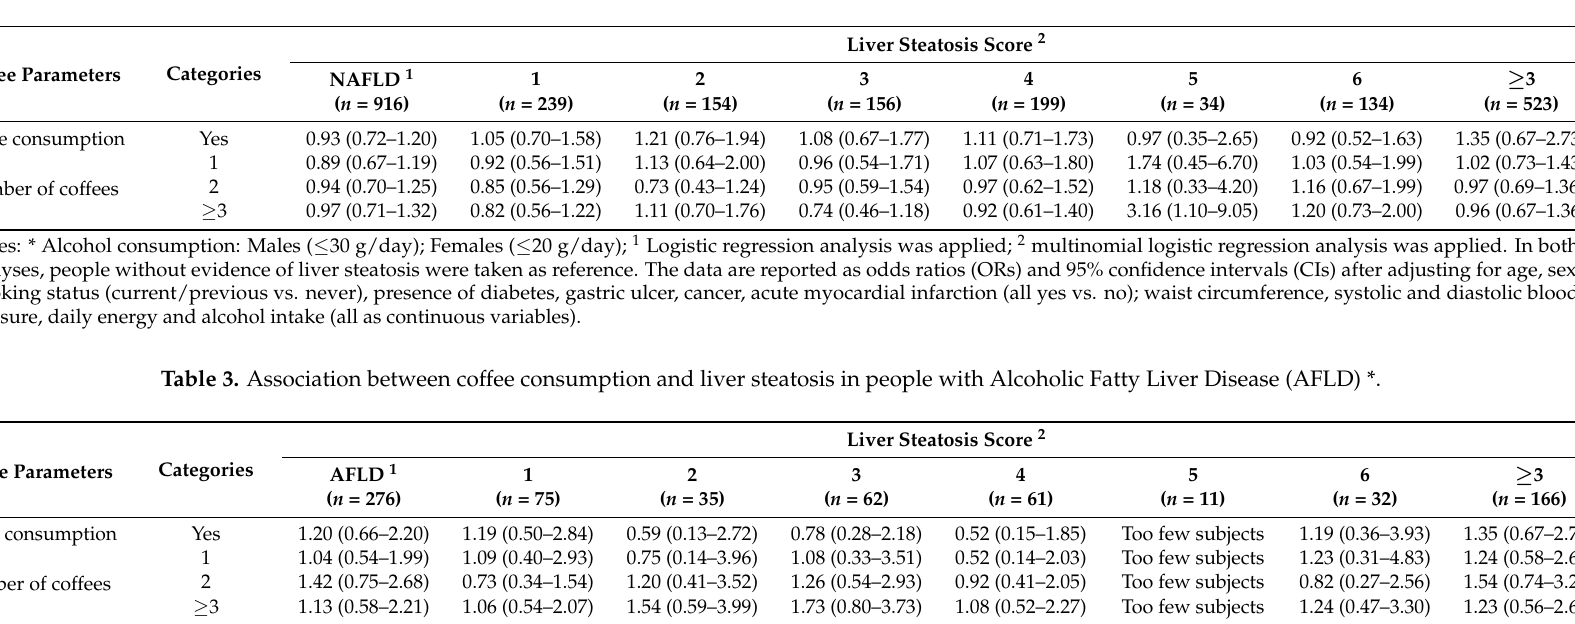
Table 2. Association between coffee consumption and liver steatosis in people with Non-alcoholic Fatty Liver Disease (NAFLD) *.